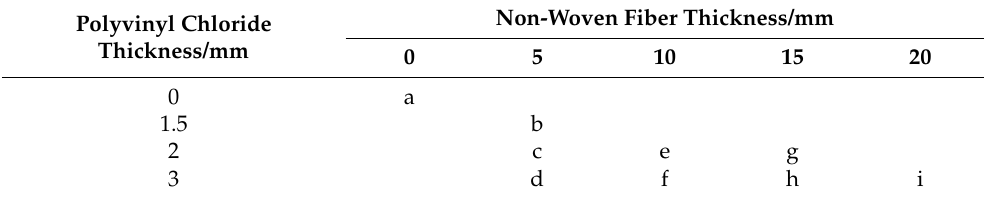
Table 1. Experimental scheme design and number of sound insulation structures.